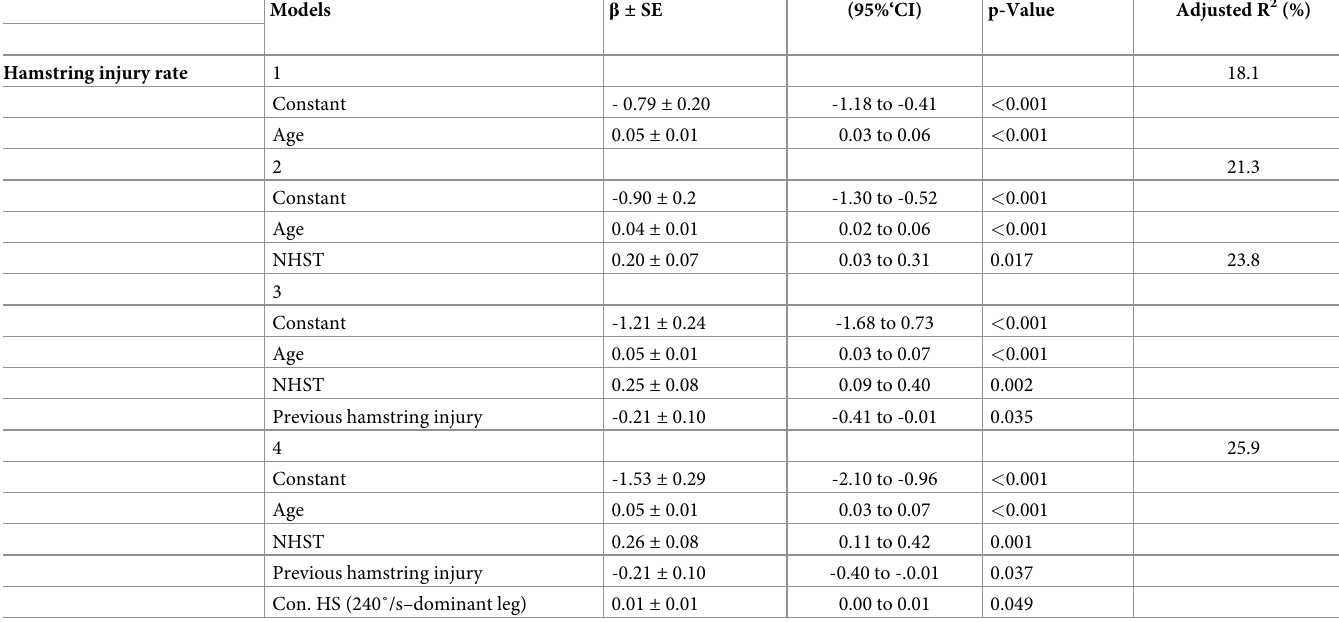
Table 5. Multiple linear regression models.